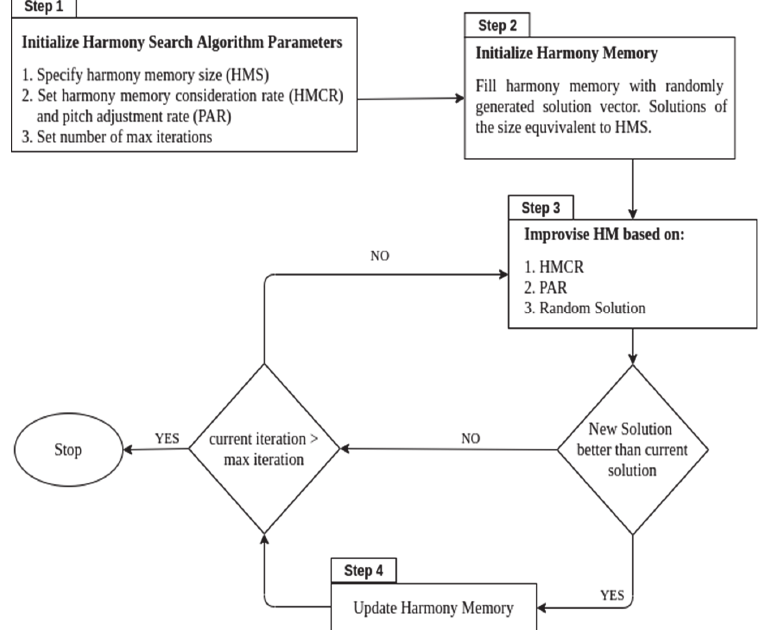
Fig. 2. Basic harmony search algorithm procedure